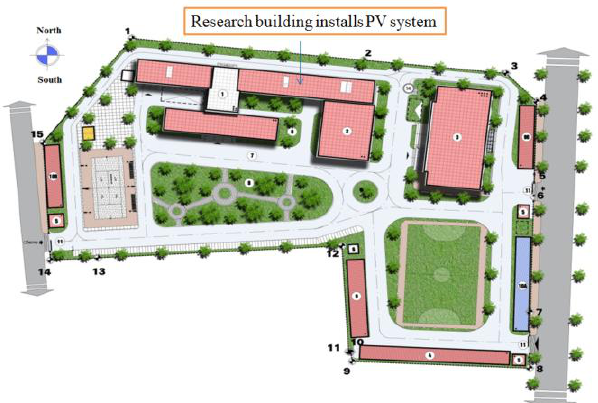
Figure 4. Plan of